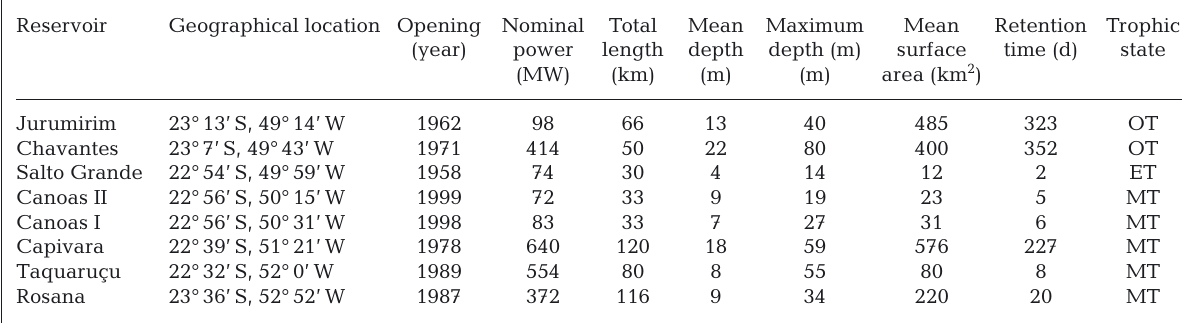
Table 1. Morphometric characteristics of the Paranapanema River reservoirs. Adapted from Felisberto & Rodrigues (2005) and Duke Energy Brasil (2013). OT: oligotrophic, ET: eutrophic, MT: